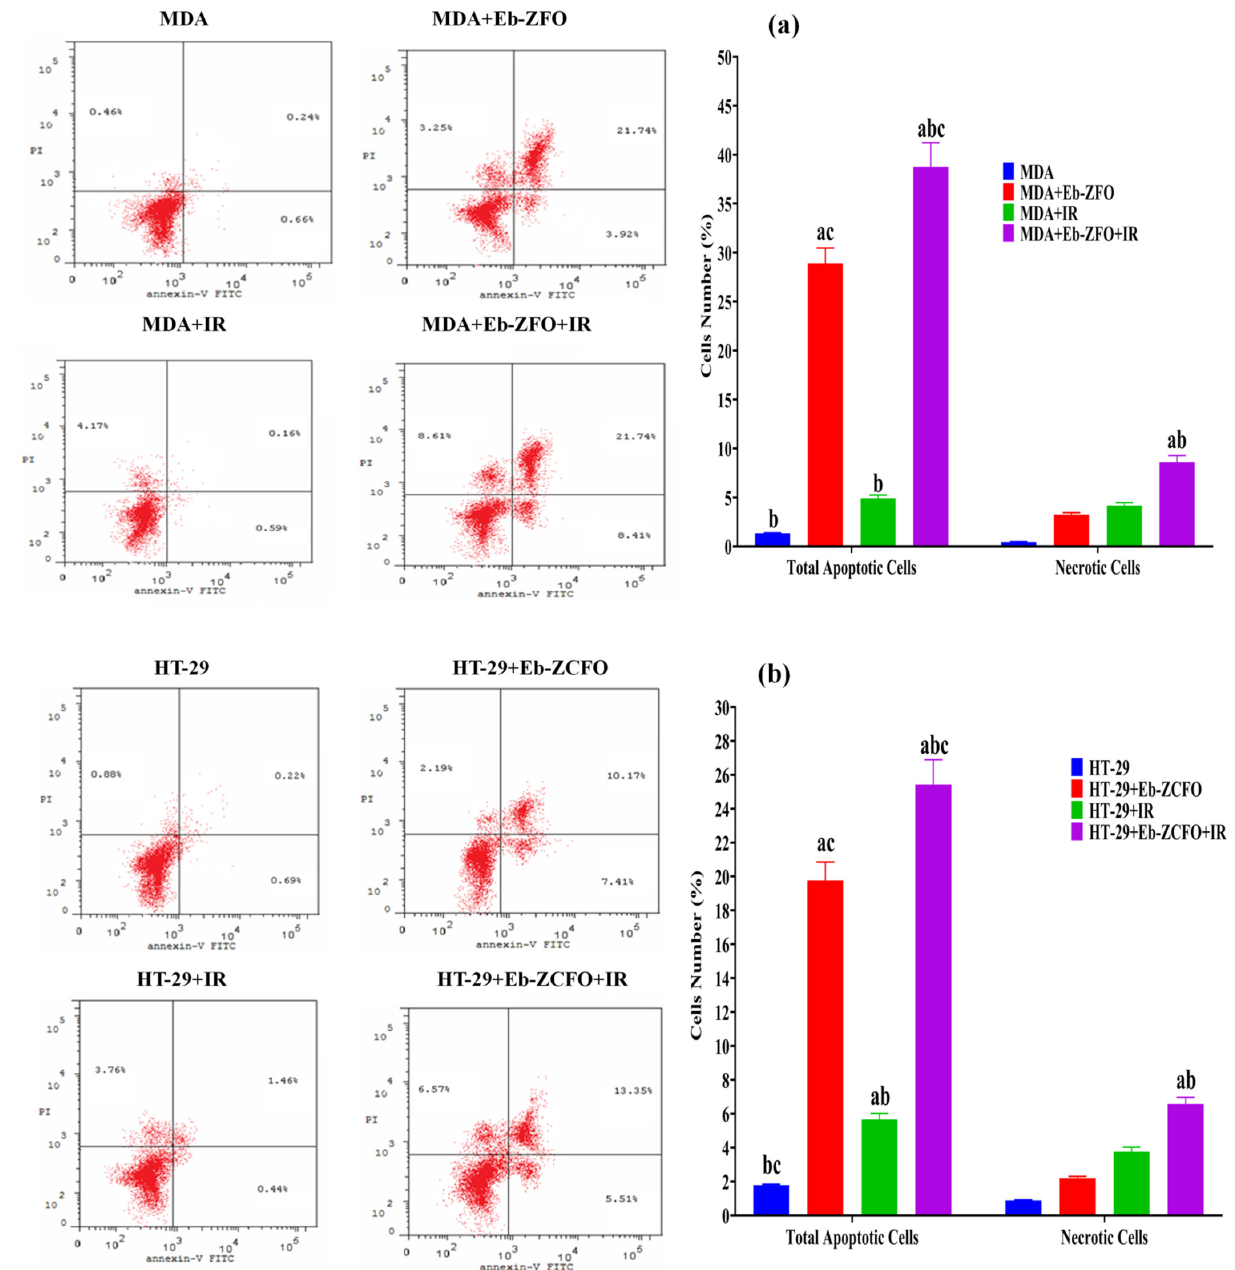
Figure 20. Detection of apoptosis via flow cytometry. ( a ) Eb-ZFO and IR induced apoptosis and necrosis in MDA-MB-231 cells after 24 h. The upper-left panel shows representative images of cell apoptosis. The percentage of apoptotic and necrotic cells was determined and is represented in the upper-right panel. MDA group: untreated MDA-MB-231 cells line served as control. MDA + Eb-ZFO group: MDA-MB-231 cells treated with Ebselen (Eb) and ZnFe 2 O 4 nanoparticles (ZFO). MDA + IR group: MDA-MB-231 cells exposed to γ -radiation. MDA + Eb-ZFO + IR group: MDA-MB-231 cells treated with Eb-ZFO and exposed to IR. ( b ) Eb-ZCFO and IR induced apoptosis and necrosis in HT-29 cells after 24 h. HT-29 group: untreated HT-29 cells served as control. HT-29 + Eb-ZCFO group: HT-29 cells treated with Ebselen (Eb) and ZnCe 0.06 Fe 1.94 O 4 nanoparticles (ZCFO). HT-29 + IR group: HT-29 cells exposed to γ -radiation. HT-29 + Eb-ZCFO + IR group: HT-29 cells treated with Eb-ZCFO and exposed to IR. The lower-left panel shows representative images of cell apoptosis. The percentage of apoptotic and necrotic cells was determined and is shown in the lower-right panel. The results are expressed as the mean and standard error of the mean (SEM) (n = 3). Columns with a, b, and c letters overhead within the same phase are significantly different from control, treated group, or IR group of each cell line at p < 0.05.